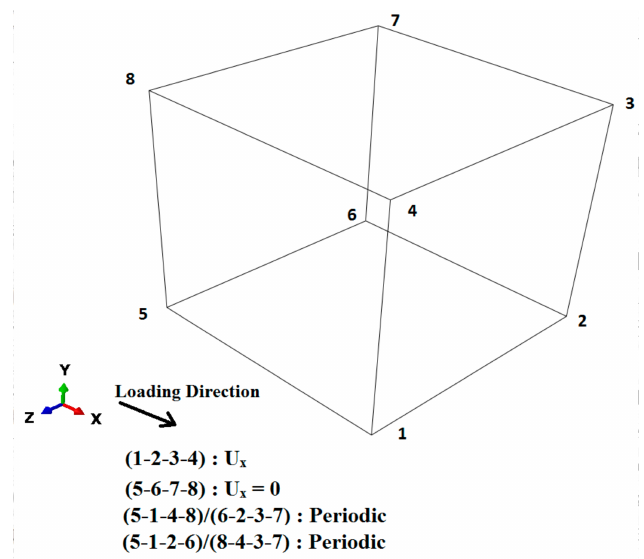
Figure 6. Boundary conditions for crystal plasticity finite element (CPFE) modeling.